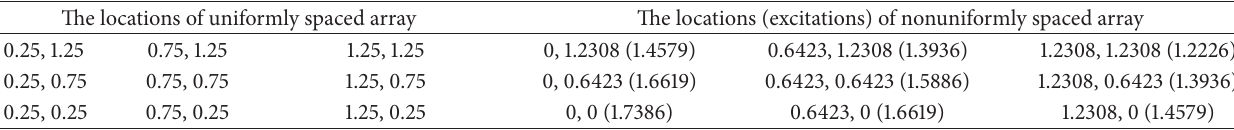
Table 1: The locations (excitations) of uniformly and nonuniformly spaced arrays.